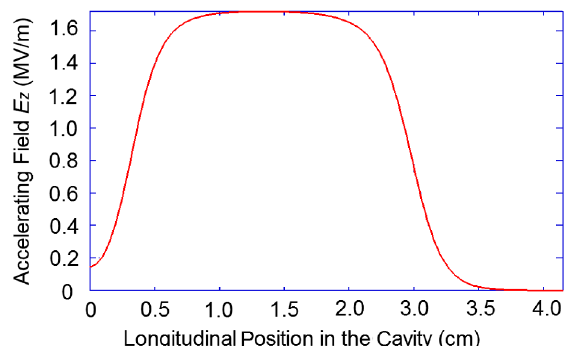
FIG. 10. The gun geometry used in EGUN simulations. The electrostatic equipotential lines are coded by color such that dark blue and dark red correspond to the maximum negative and zero potential,